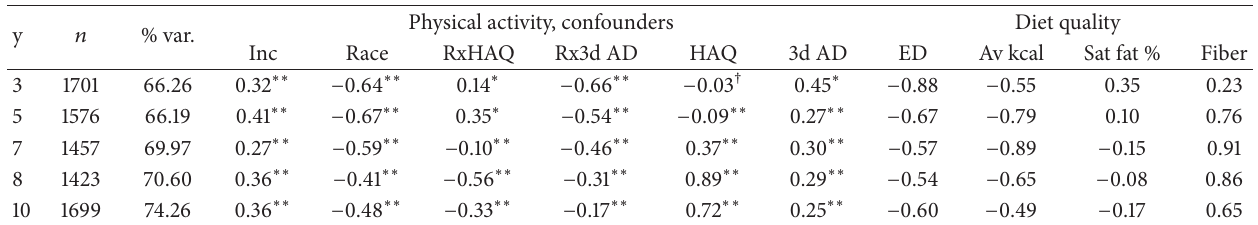
Table 1: Canonical correlation analysis evaluating physical activity and confounders with diet quality indicators. Percent variance explained by first indices and first indices’ standardized canonical coefficients by visit year.